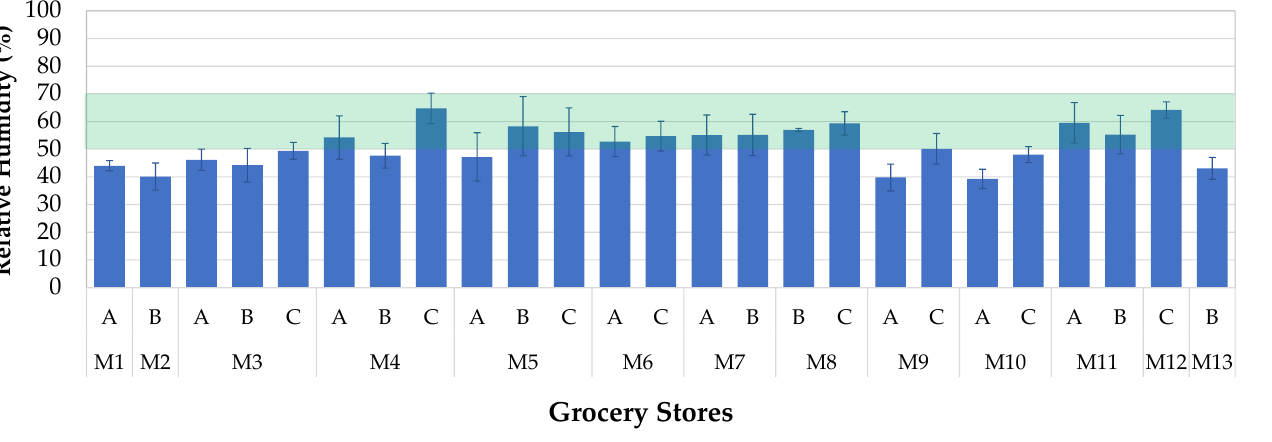
Figure 3. Relative humidity levels assessed in all locations of the studied GSs. The green area represents the acceptable range (50% – 70%) for workplaces defined by Portuguese Legislation [31].